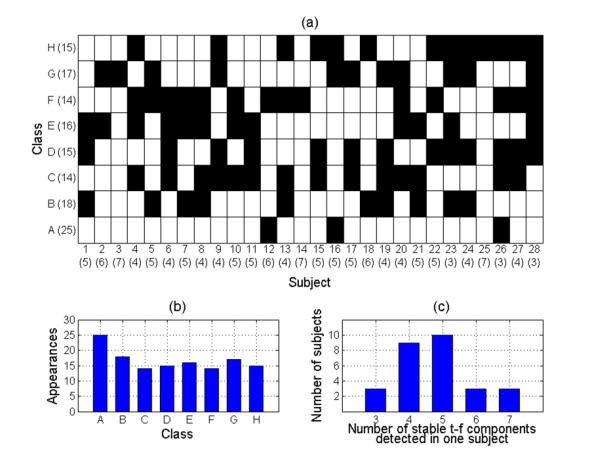
Appearances of stable t-f components in each individual rat subject. (a) Stable t-f components detected in each individual subject: a white block means the corresponding t-f component can be identified in this subject, while a black block means this component cannot be found in this subject. The numbers in brackets after the component names are the appearances of components, while the numbers in brackets below the subject number are the number of components detected in this subject. (b) Histogram of appearances of stable t-f components. (c) Histogram of number of stable t-f components detected in one subject.